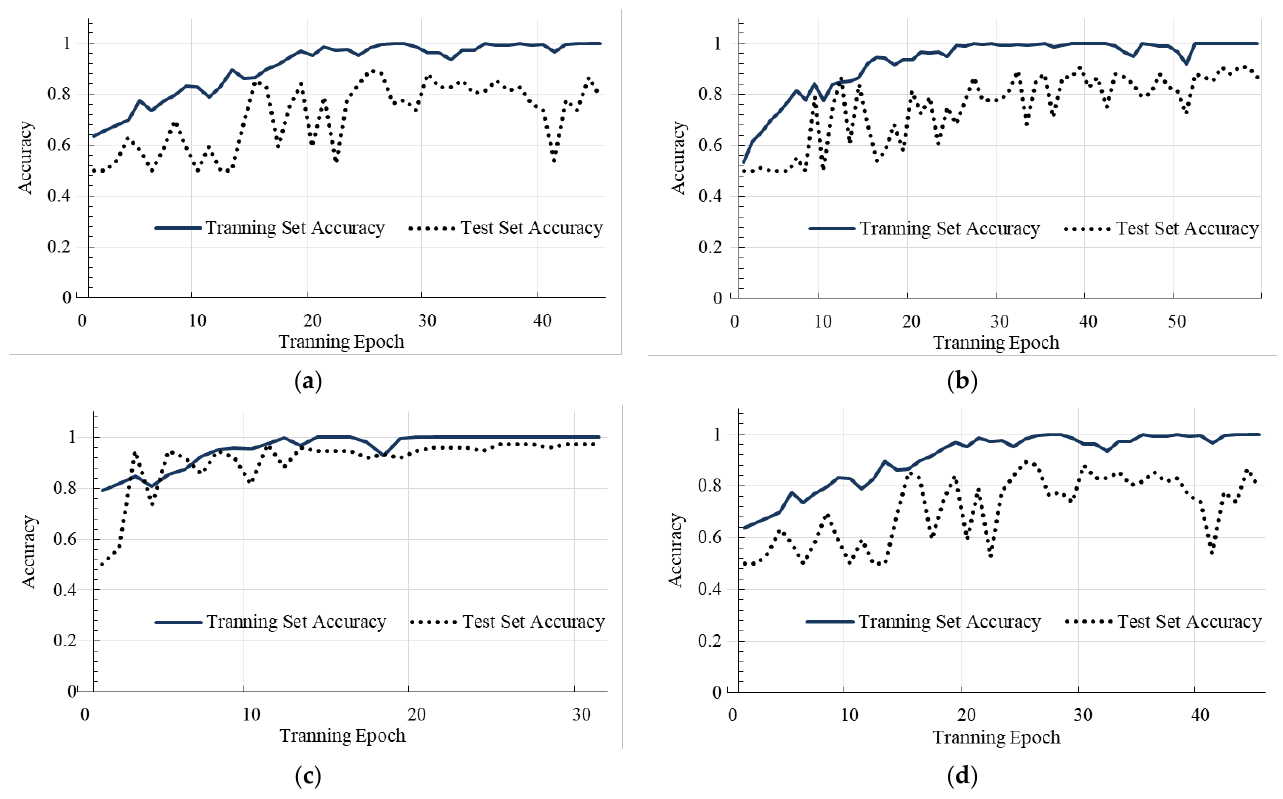
Figure 10. Accuracy plot of training and test sets of four different emotions in RAVDESS dataset for Stage 2 (Intensity Measure) in Cascaded DL framework. ( a ) Happy Emotion; ( b ) Sad Emotion; ( c ) Angry Emotion; ( d ) Fearful Emotion. Table 4. The test set confusion matrix by the Cascaded DL framework for emotion recognition with intensity